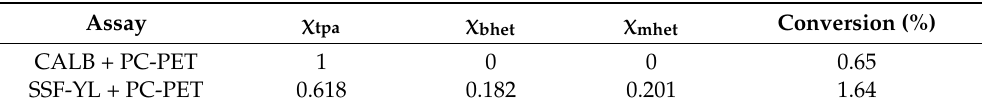
Table 2. Conversion and molar fractions after 168 h of reaction using PC-PET as the hydrolysis substrates at 37 ◦ C and 180 rpm. Assay χ tpa χ bhet χ mhet Conversion